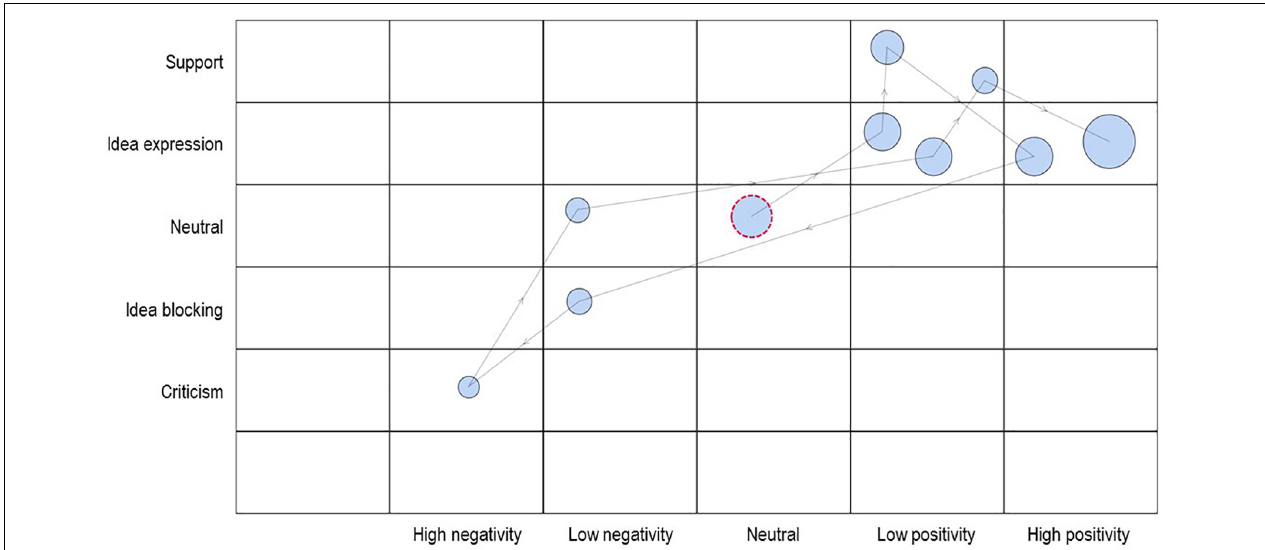
FIGURE 1 | An example of using a state space grid to display the first 10 events of a hypothetical brainstorming session. The team’s energy level is plotted on the x -axis and coded talk is plotted on the y -axis.